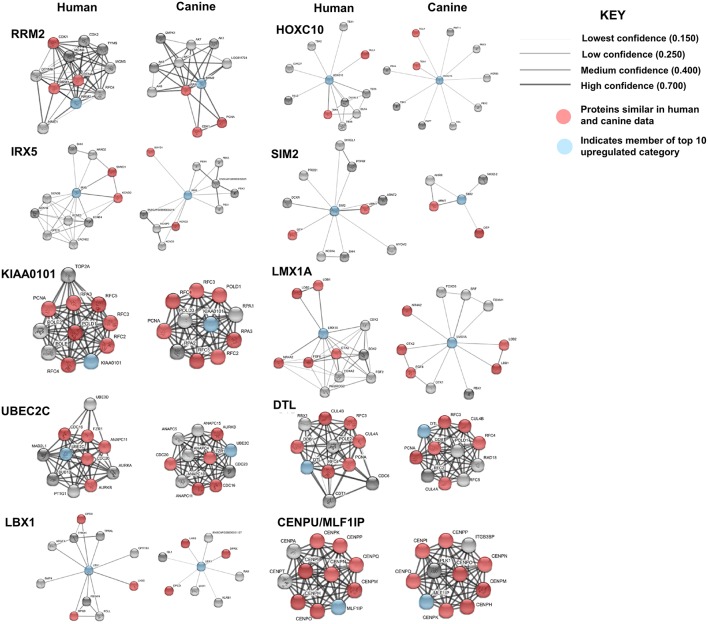
Comparison of suggested protein associations of top 10 upregulated genes in humans and canines. Data was collected using the STRING database (functional protein association network version-10-5) at medium confidence (0.400). Increasing confidence is demonstrated by increased thickness and darkness of edges (intersecting lines). Red notes indicate proteins involved in similar associations in both humans and canines. Blue nodes indicate proteins that are members of the top 10 upregulated category.